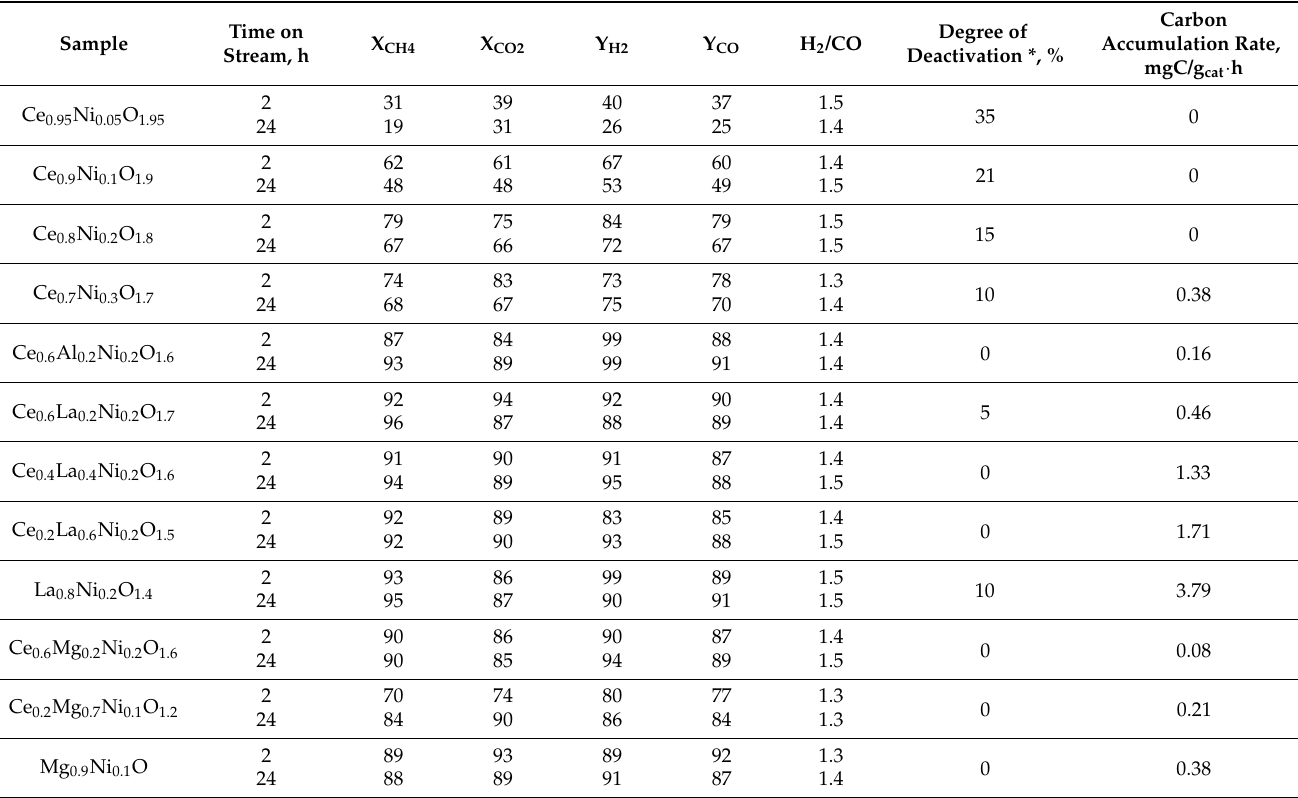
Table 4. Effect of Ni molar fraction (x), type of M, and molar ratio M/Ce on the parameters of